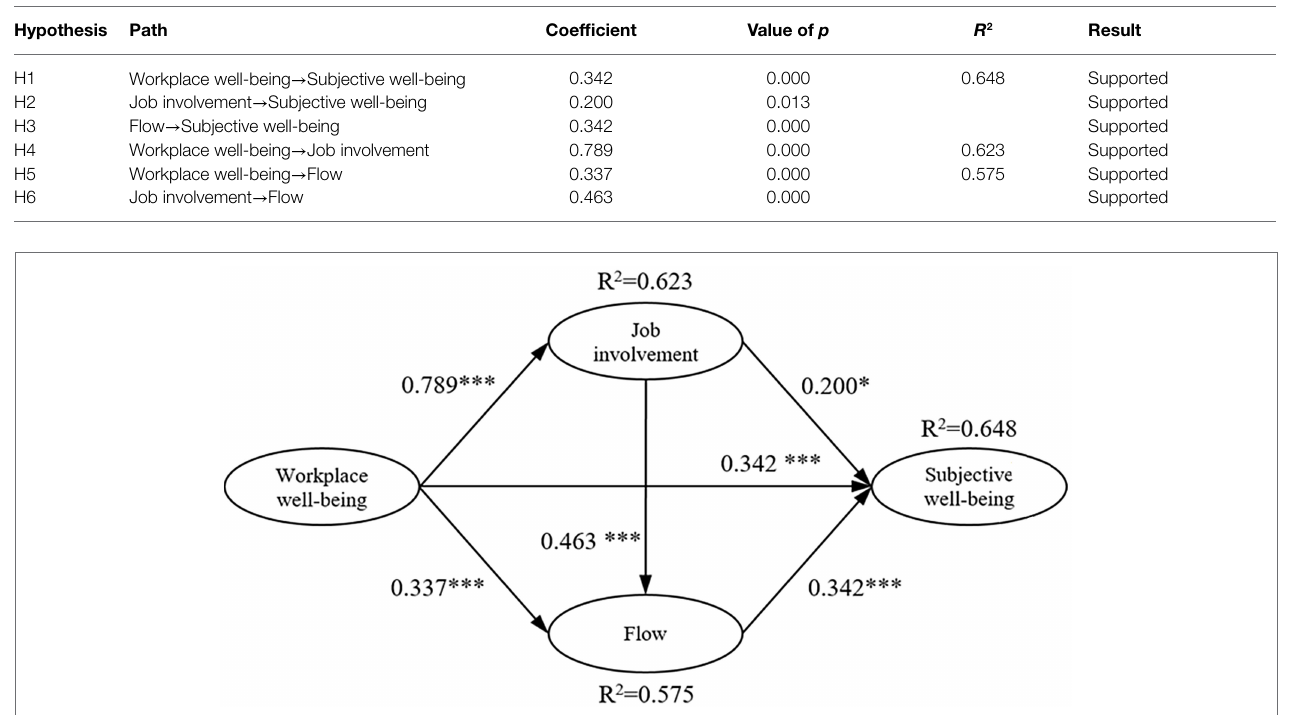
FIGURE 2 | Research framework path analysis diagram. TABLE 9 | Indirect effect analysis.